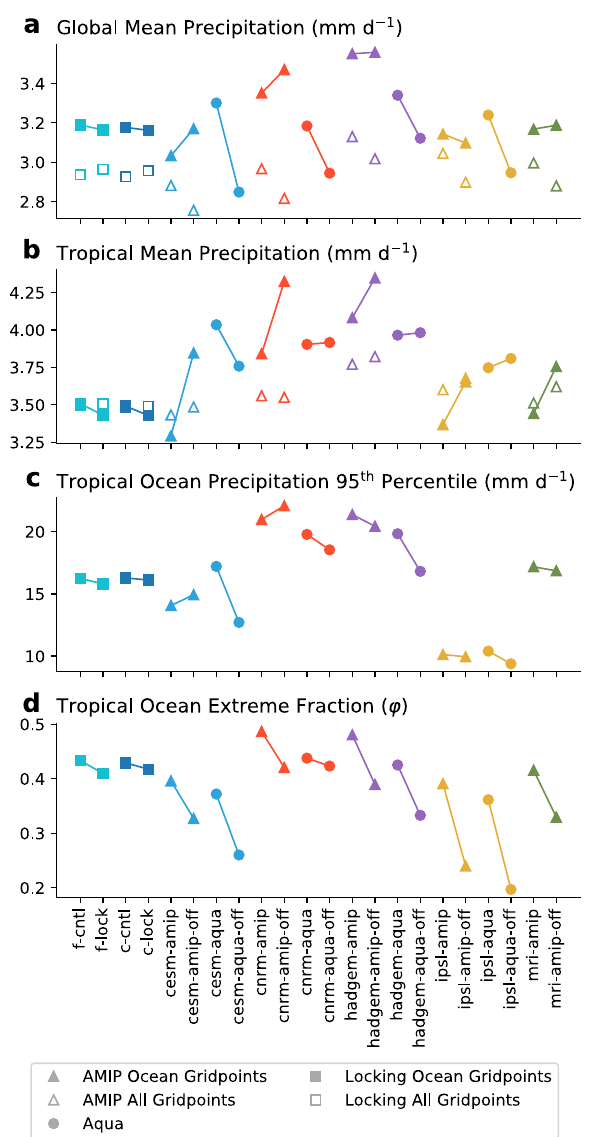
Fig. 2 Summary statistics from the experiments. Lines connect pairs of simulations to highlight the changes over oceans. Panels a and b separately show ocean gridpoints ( fi lled markers) and all gridpoints (open markers). Colors denote models as in Fig. 1.